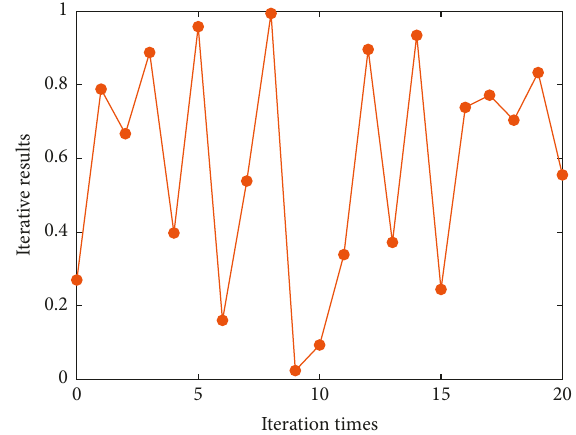
Figure 2: The output of equation (13) when μ � 4 and β